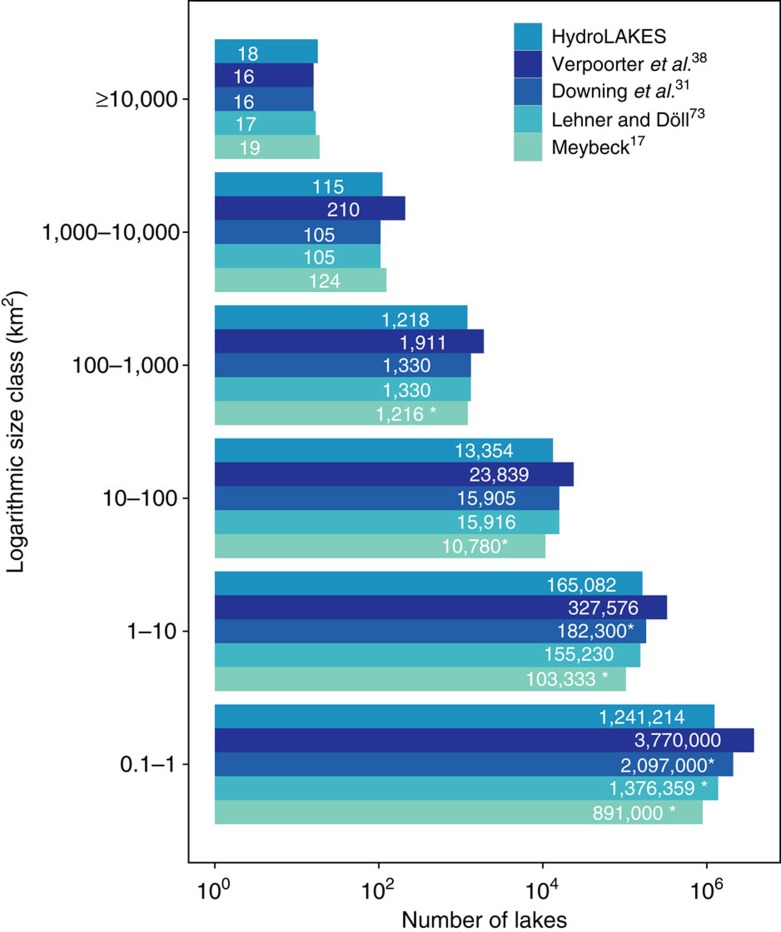
Comparison of the total number of global lakes between previous estimates and this study.Lake numbers are shown by logarithmic size class for lakes with a surface area of at least 10 ha. The asterisk (*) indicates that the numbers were extrapolated from canonical data sets with log–log regressions between the number of lakes and their surface area (as shown in Fig. 3). The number of lakes over 10 km2 for Lehner and Döll70 and Downing et al.31 are both obtained from the Global Lakes and Wetlands Database (GLWD)70. All data refer to natural lakes except Verpoorter et al.38 which include reservoirs.